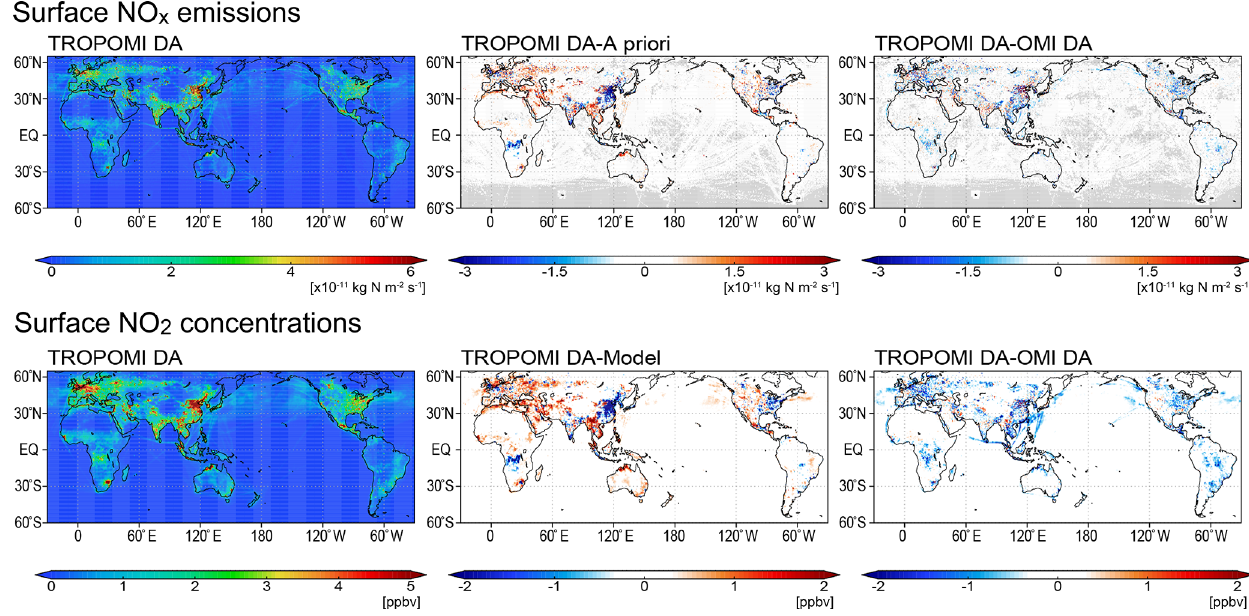
Figure 9. Global distributions of top-down NO x emission estimates (top) and surface NO 2 concentrations (bottom) provided by Tropospheric Monitoring Instrument (TROPOMI) data assimilation (DA) from 15 April–31 May 2018 (left), as well as the differences between TROPOMI DA and a priori emissions (middle) and between TROPOMI DA and Ozone Monitoring Instrument (OMI) DA (right). For the middle upper and right upper panels, grids with a gray color indicate the differences that are statistically insignificant at the 95% confidence level using the Mann–Whitney U test. The units of NO x emissions and NO 2 concentrations are × 10 − 11 kgNm − 2 s − 1 and ppbv, respectively. Table 7. Global and regional total surface and lightning NO x emissions (Tgyr − 1 ) from 15 April–31 May 2018, taken from a priori emis- sions, Tropospheric Monitoring Instrument (TROPOMI) data assimilation (DA), Ozone Monitoring Instrument (OMI) DA, EDGARv5 (for 2015) + GFED4 (for 2018) inventories, and REASv3.2 (for 2015) + GFED4 (for 2018) inventories. The ranges are the standard deviations of the time series. A priori lightning emissions are calculated in the control model simulation. A priori TROPOMI DA OMI